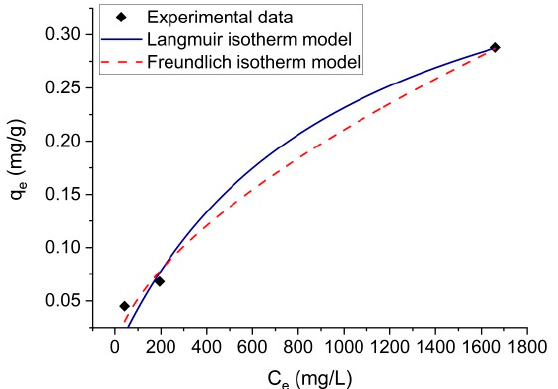
Figure 9. Plots of the Langmuir and Freundlich isotherm models for NH 3 adsorption onto thermally treated volcanic tuff.